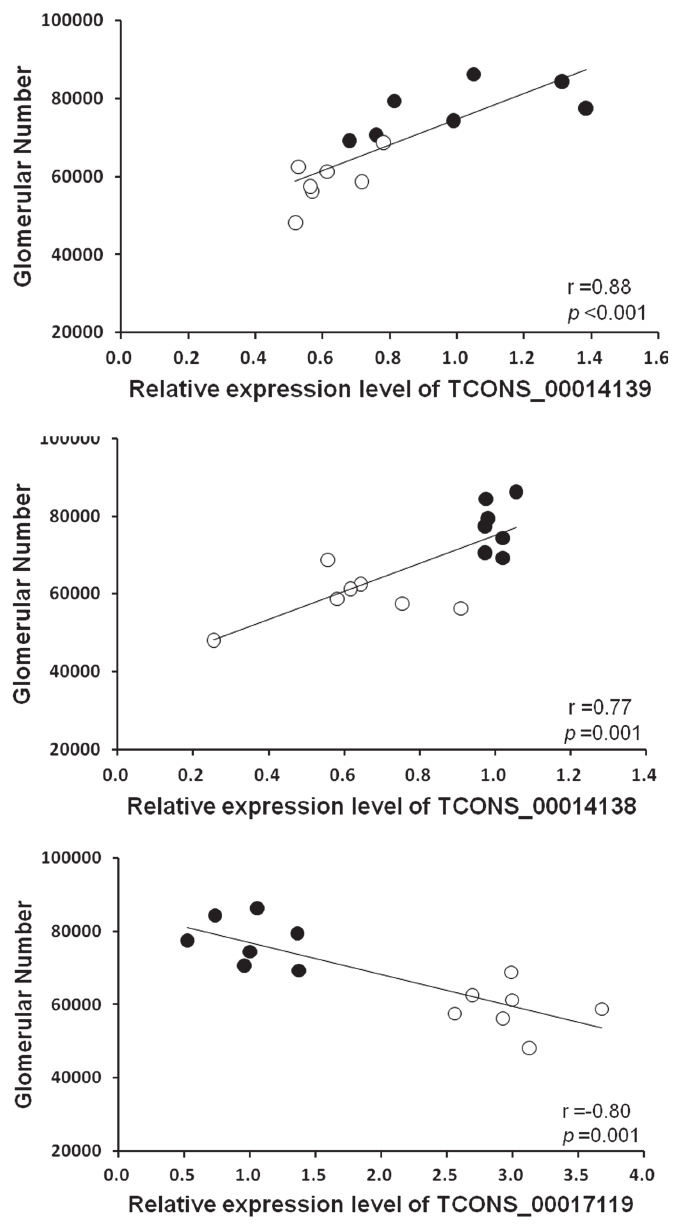
Fig 5. Correlation analysis of lncRNAs expression with glomerular number. The number of glomeruli was positively correlated with the relative expression of lncRNAs TCONS_0014139 (A: r = 0.88; p < 0.001; n = 14) and TCONS_00014138 (B: r = 0.77; p = 0.001; n = 14), but negatively with lncRNA TCONS_00017119 (C: r = -0.80; p = 0.001; n = 14) in the kidneys at postnatal day 10 (p10). Black circles, control rats (n = 7); open circles, low birth weight rats (n = 7). The level of lncRNA was calculated relative to GAPDH. The data are expressed as relative to the controls at p10. r = Spearman ’ s correlation